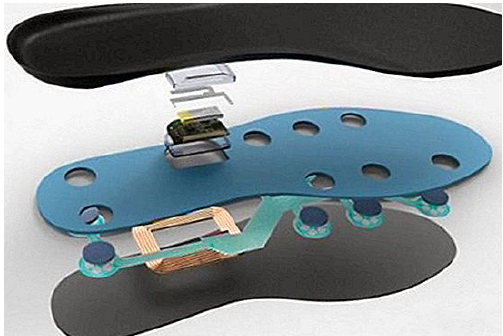
Figure 1. Design of the shoe insole used in our